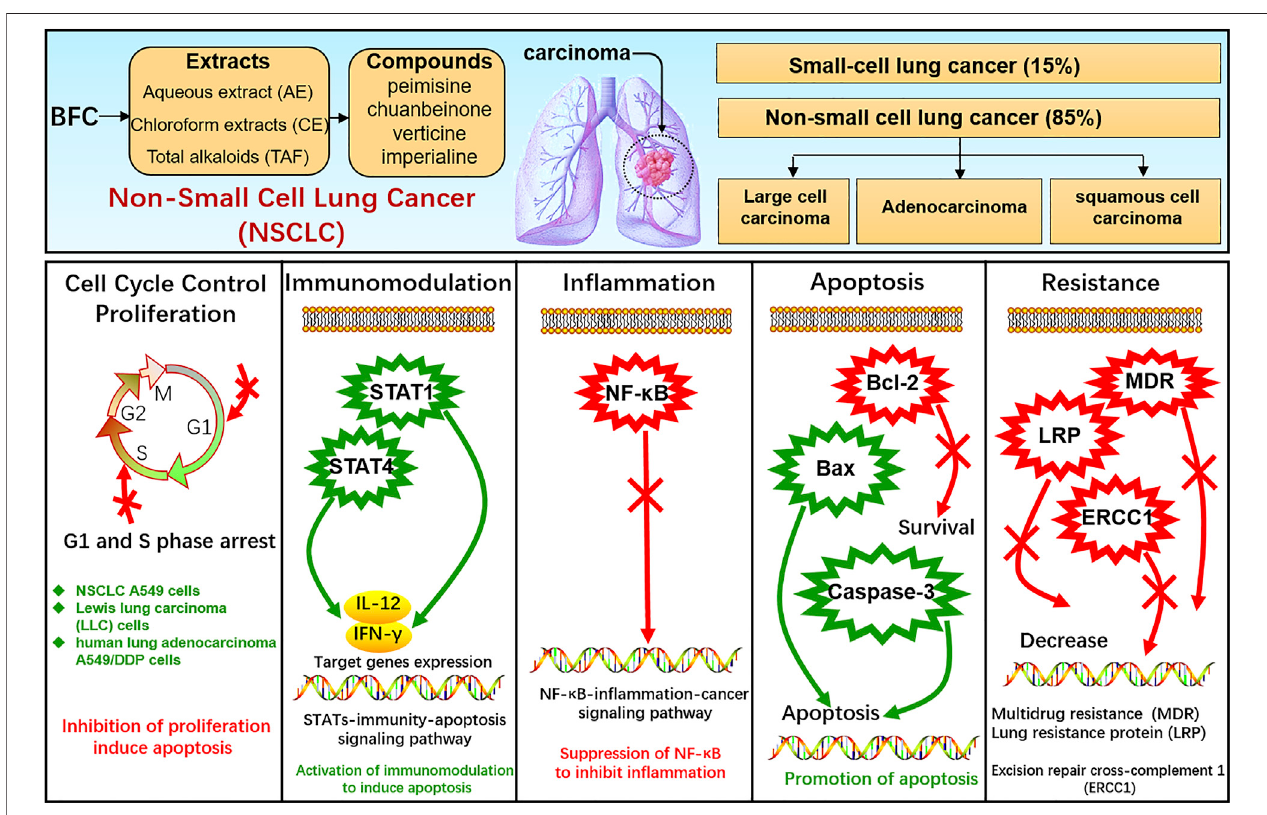
FIGURE 6 | The mechanism of BFC in the treatment of lung